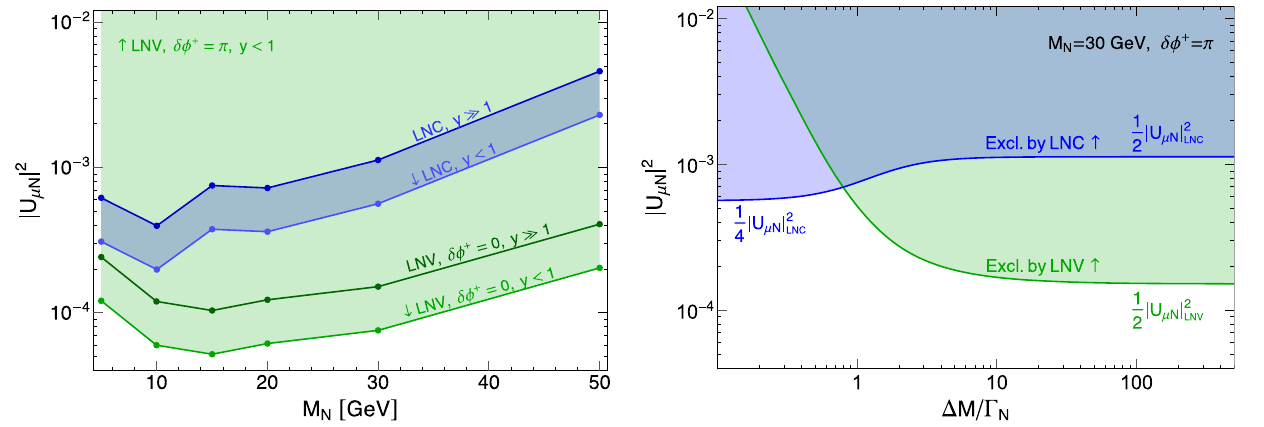
(lower green region) if δφ + = 0. Right: | U μ N | 2 as a function of y , with M N = 30 GeV and δφ + = π . Blue (green) region is for LNC (LNV) channel with the thick lines corresponding to the (rescaled) LHCb bounds to the case of a low-scale seesaw with pseudo-Dirac HNL